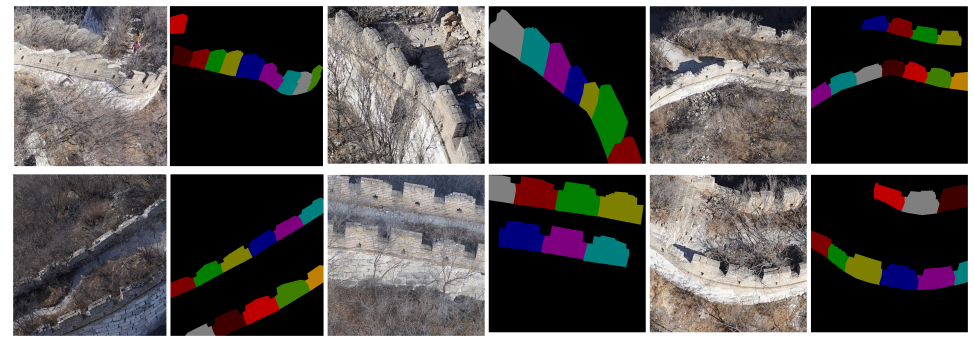
Figure 6. Illustration of the JKGW_WHU